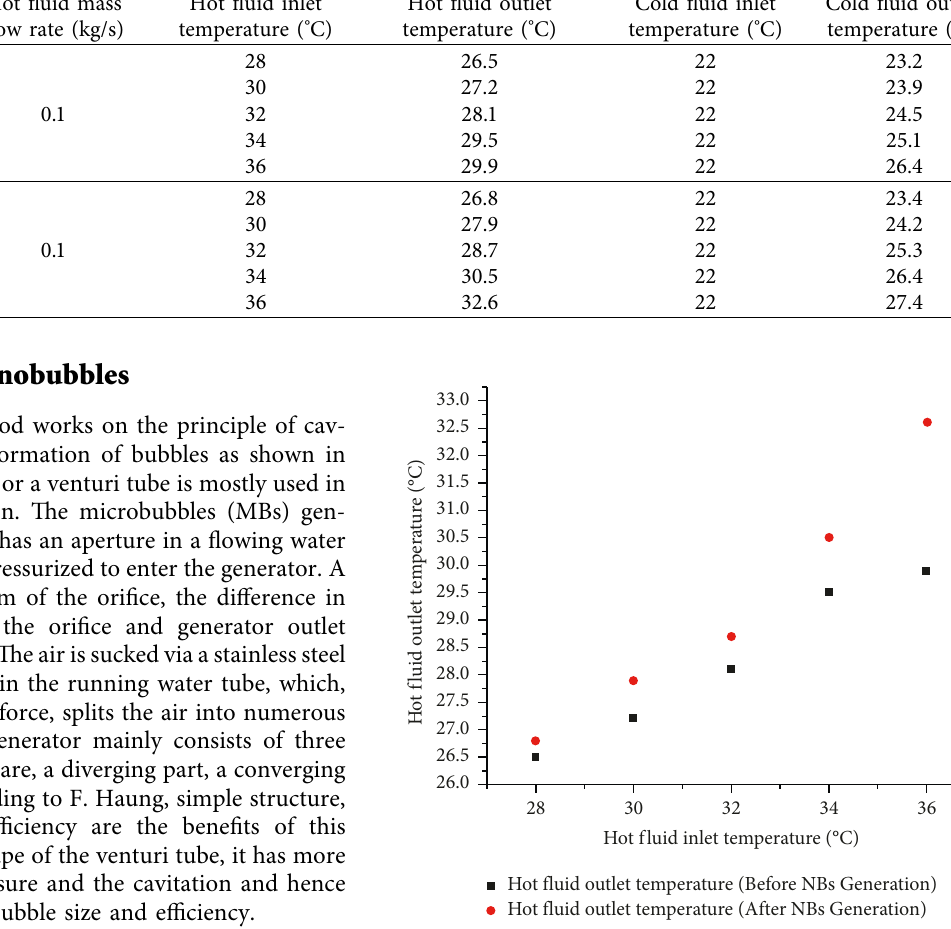
Figure 2: Influence of nanobubbles on hot fluid (water-ethylene glycol) outlet